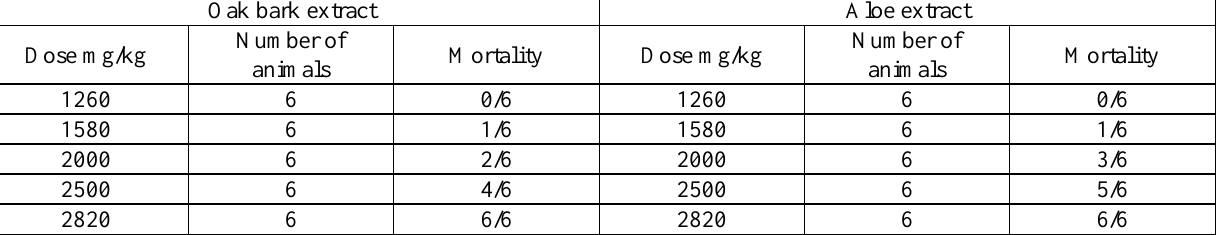
Study of acute toxicity of components of a new gel: extract of oak and oak bark extract under intraperitoneal injection to rats